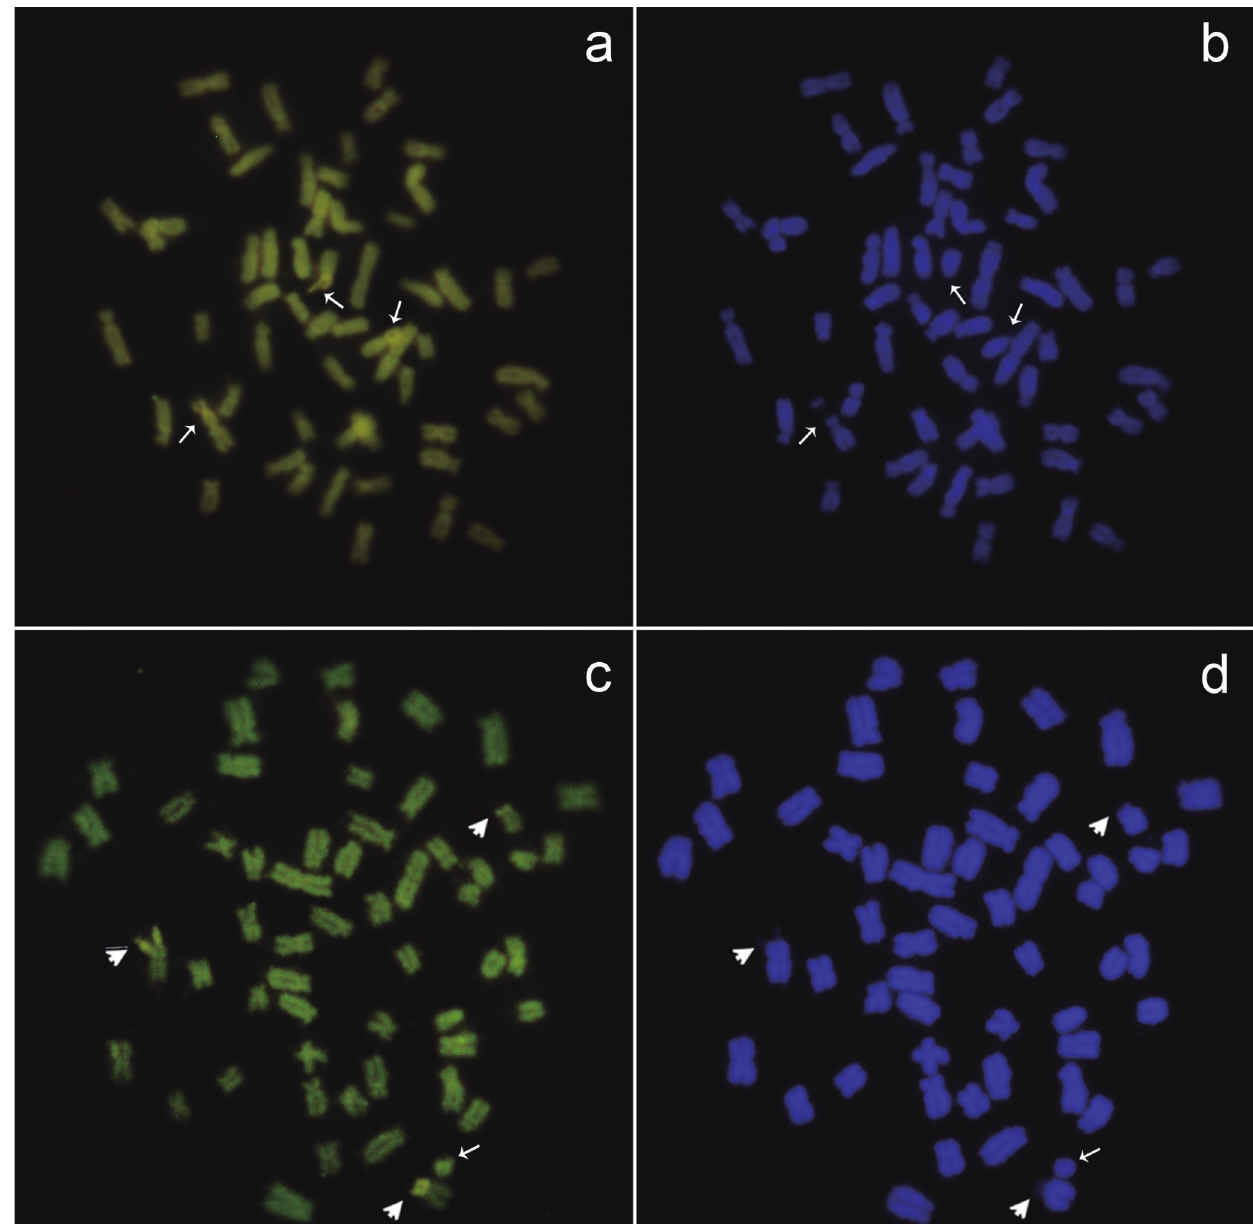
Fig. 3. Callichthys callichthys metaphases spreads with the third NOR bearing chromosome. The arrowheads indicate the NORs, marked in the interstitial position stained by (a) CMA by (c) CMA and confirmed by (d) DAPI. The bar represents 3